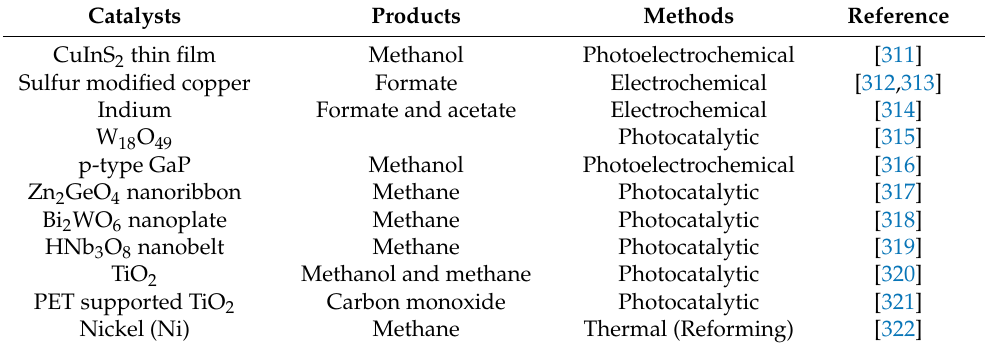
Table 10. List of catalysts utilized in CO 2 conversion processes to manufacture valuable products.